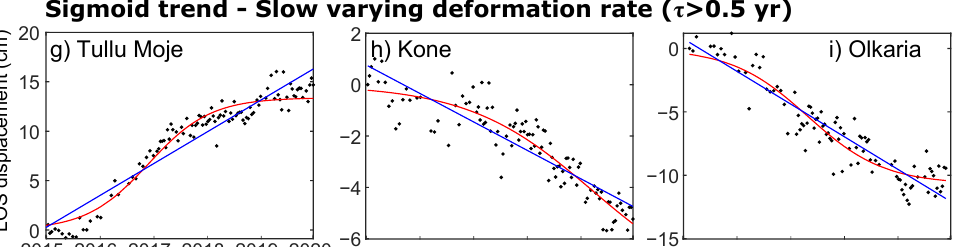
Sigmoid trend - Slow varying deformation rate ( 𝛕 >0.5